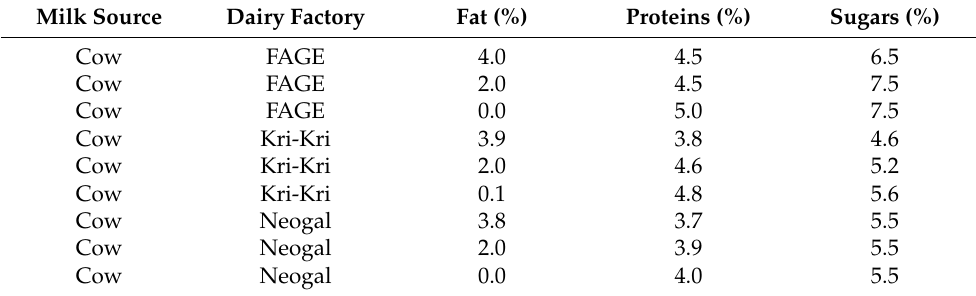
Table 2. Gross composition of cow yogurts with different fat